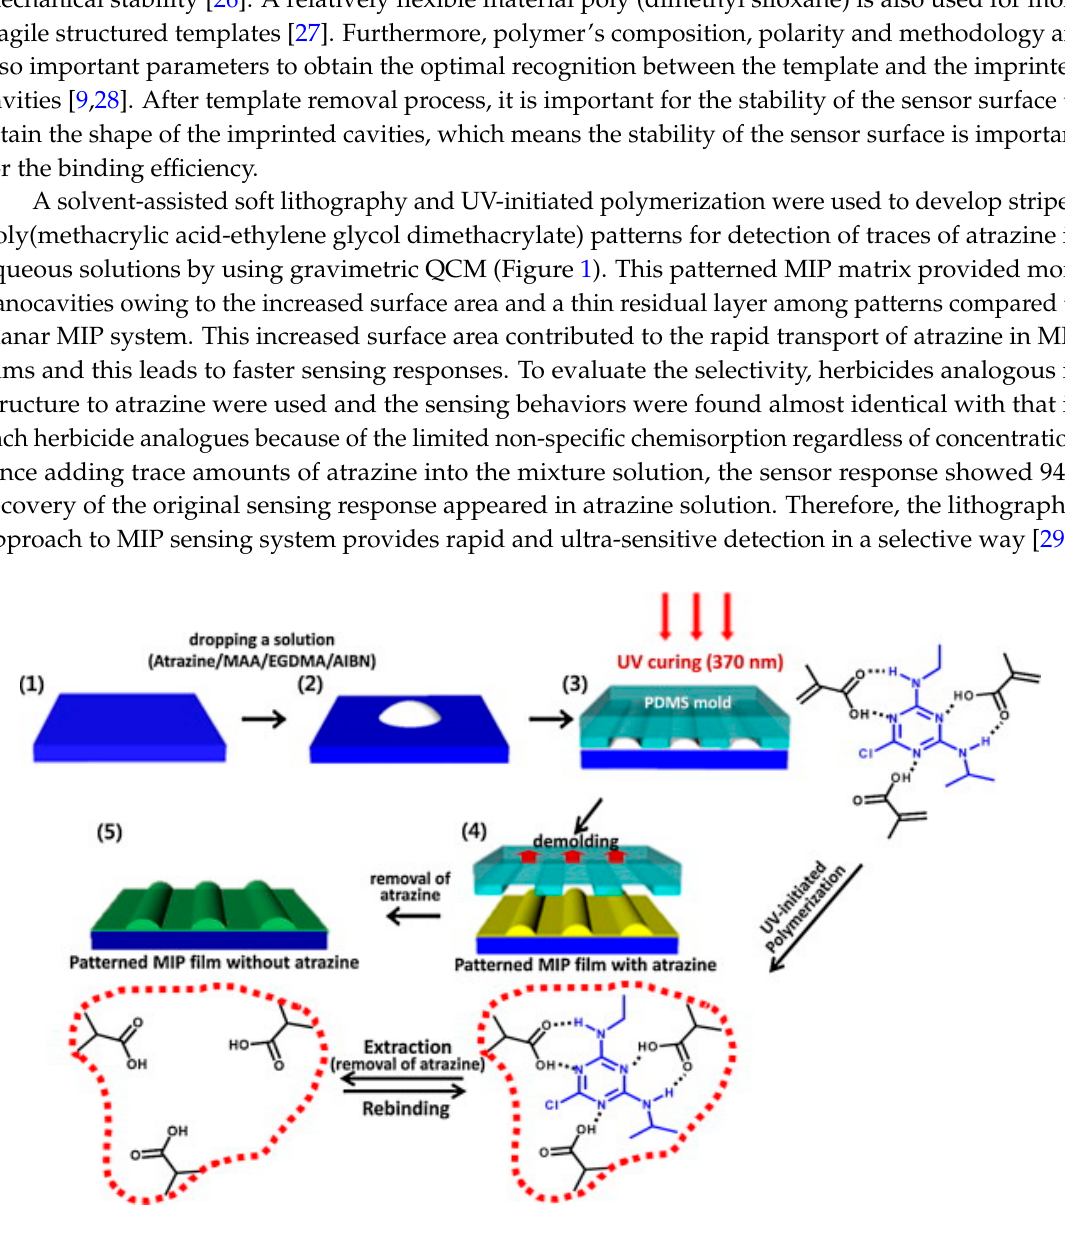
Figure 1. Schematic representation of fabrication process of patterned MIP films via soft lithography and UV polymerization. ( 1 – 2 ) Imprinting solution containing the template molecule, functional and cross-linking monomers and initiator was dropped on the substrate. ( 3 ) The patterned PDMS mold was placed on the droplet of solution under certain pressure to ensure enough physical contact between the PDMS and substrate. Then, UV polymerization was initiated and continued for 7–10 min. ( 4 ) Following de-molding, the patterned MIP films were dried at 60 °C. ( 5 ) In the last step, template molecule (atrazine) was removed from the surface (reproduced from [29] with permission).